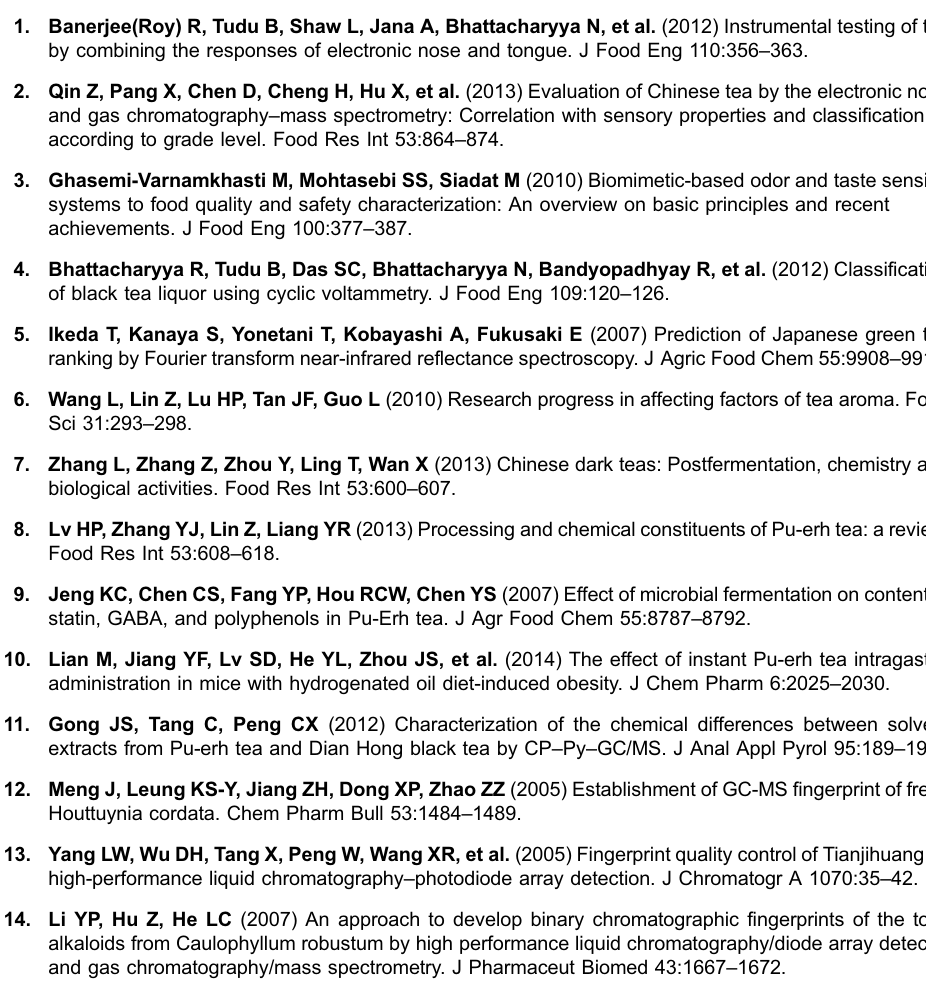
S2 Fig. SPME/GC-MS chromatogram of volatile compounds in A2 tea samples. doi:10.1371/journal.pone.0116428.s002 (TIFF) S3 Fig. SPME/GC-MS chromatogram of volatile compounds in A3 tea samples. doi:10.1371/journal.pone.0116428.s003 (TIFF) S1 Table. GC-MS analysis results of volatile compounds in 3 Ya’an dark tea